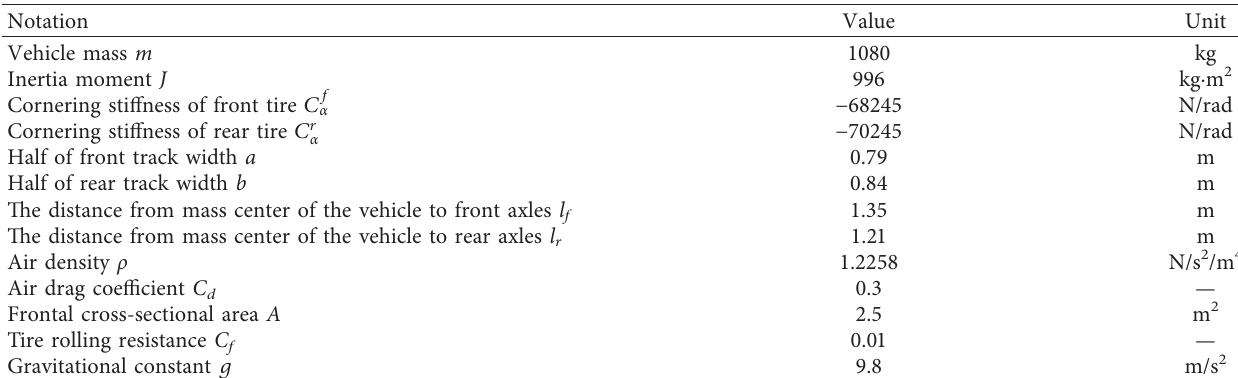
Figure 4: The trajectories of coordinates X C and Y C govern by equation (12) with a circular reference path and various control parameters introduced. Table 1: Parameters used in the vehicle